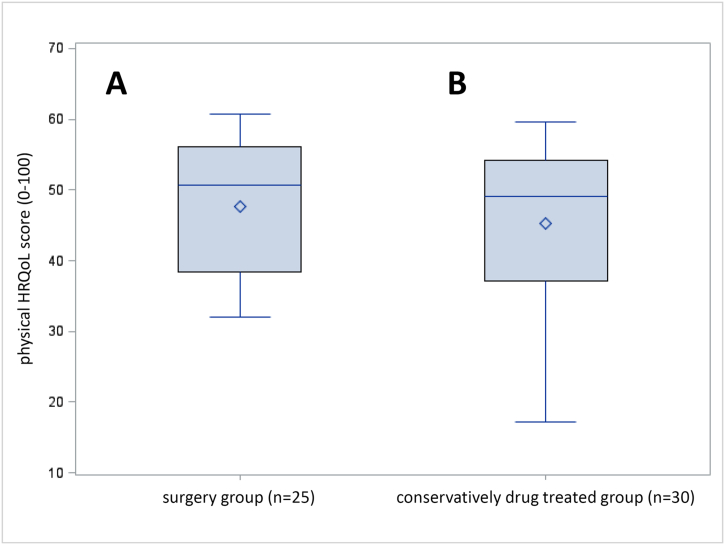
Boxplot representation of the physical sum scale after surgical (A) and drug therapy (B).